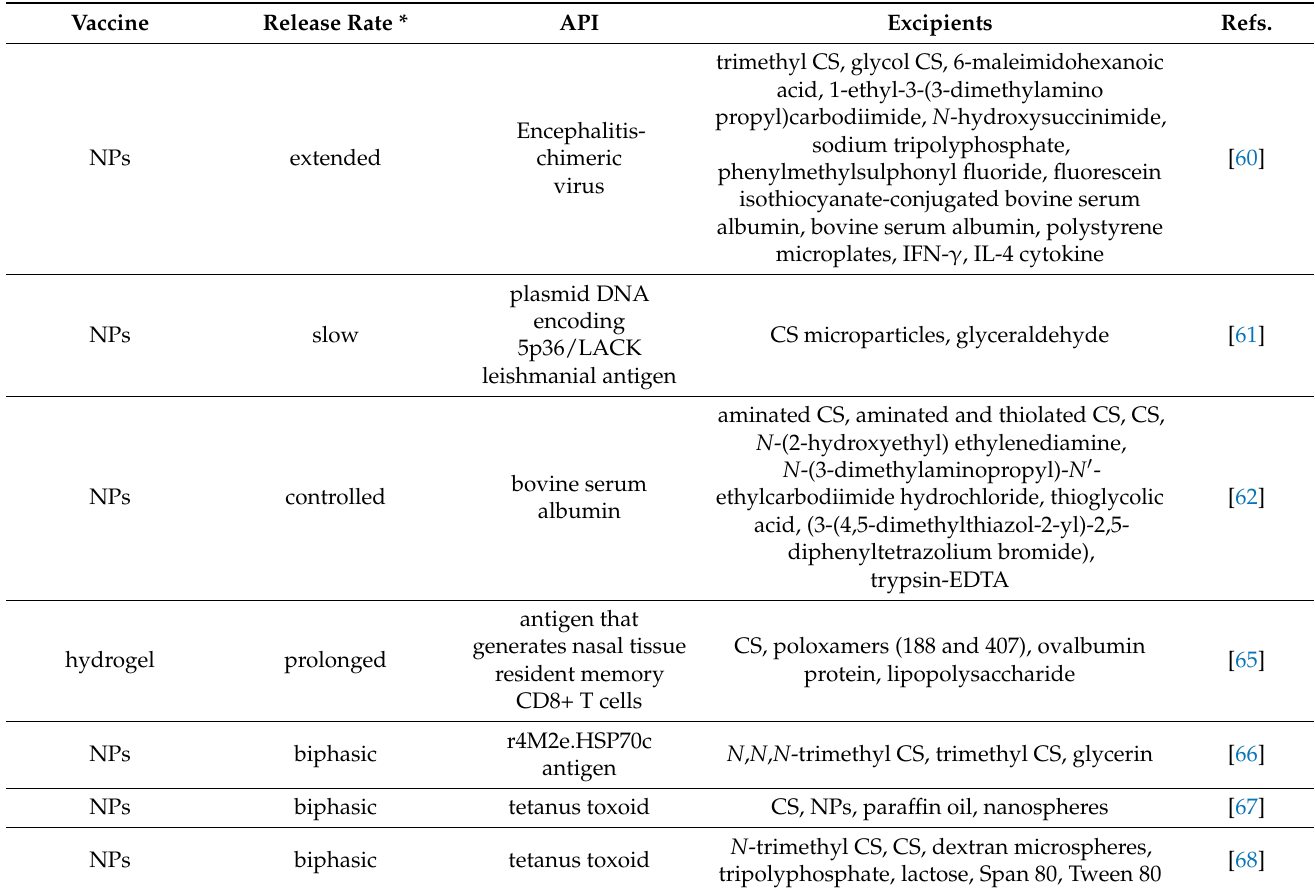
Table 3. Vaccines for modified release intranasal